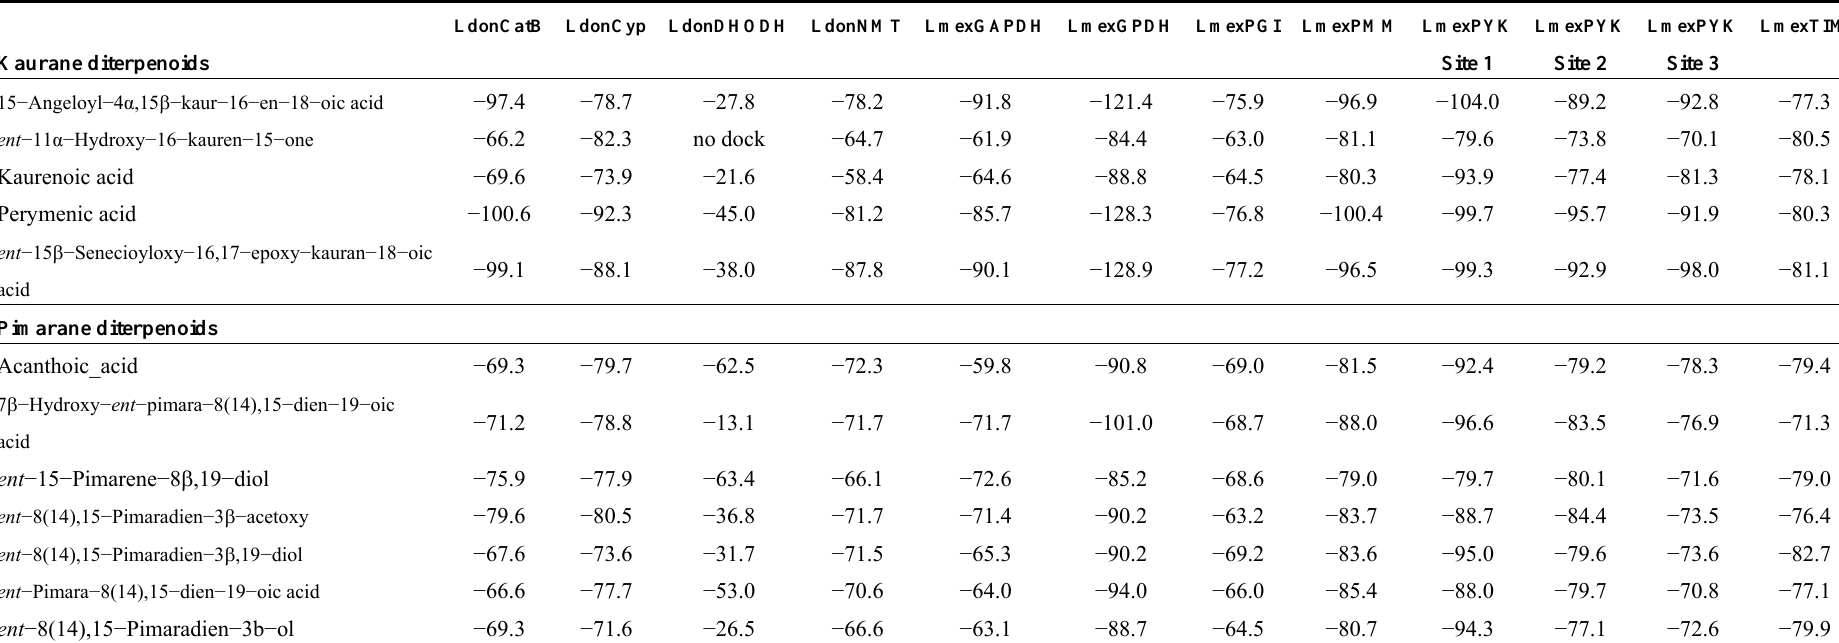
Table 25. MolDock docking energies (kJ/mol) of kaurane and pimarane diterpenoids with Leishmania donovani and L. mexicana protein